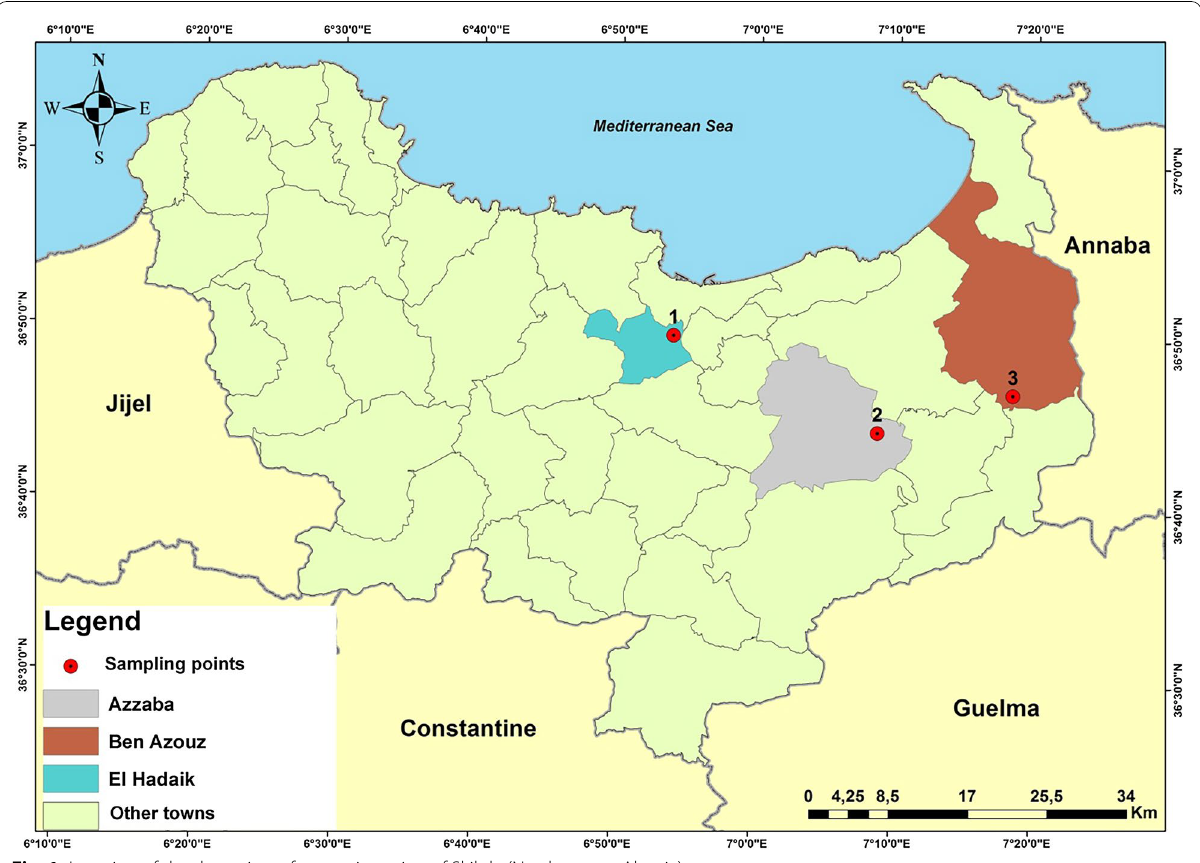
Fig. 1 Location of the three sites of survey in region of Skikda (Northeastern